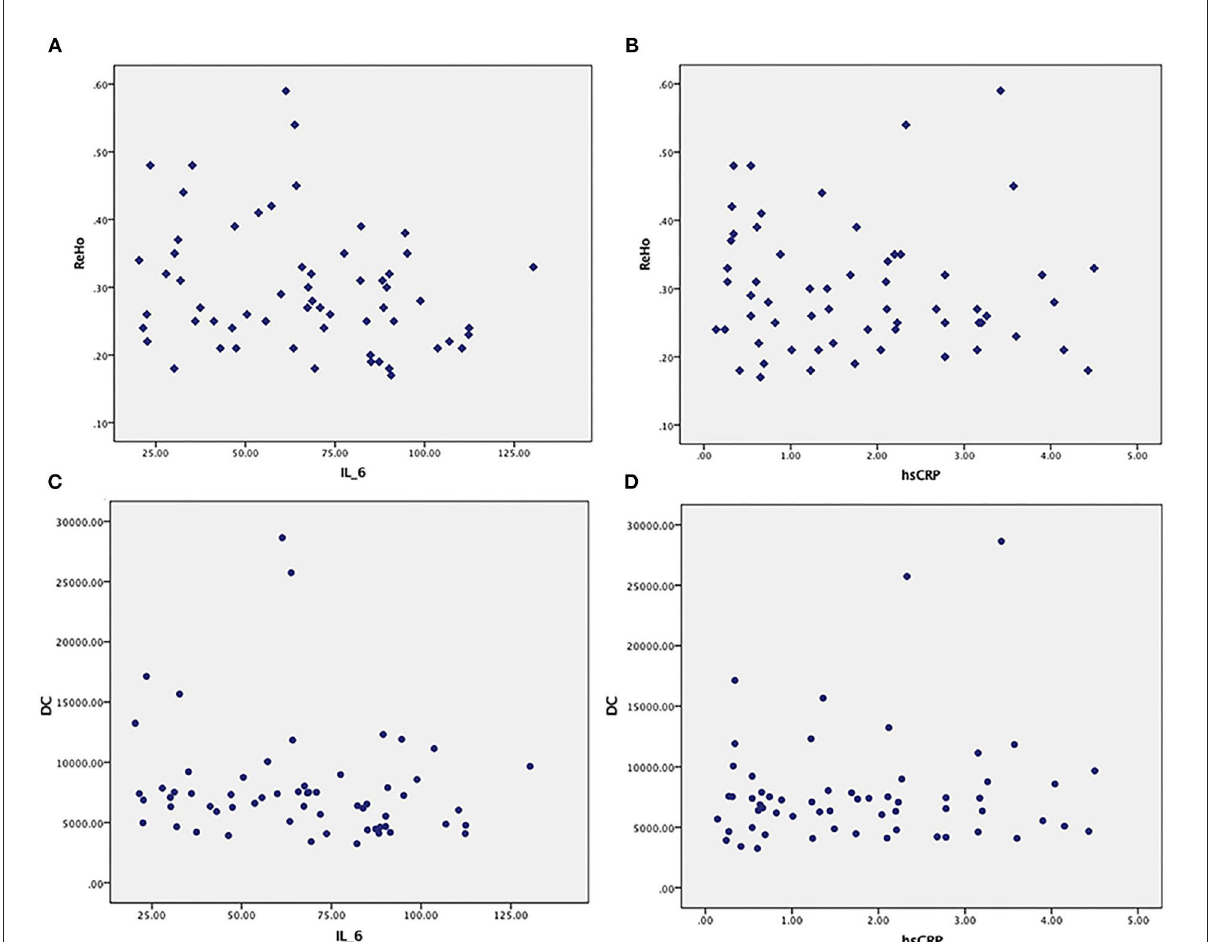
FIGURE5 (A,B) No obvious relationship between ReHo in abnormal brain regions and serum IL-6 or CRP. (C,D) No obvious relationship between DC in abnormal brain regions and serum IL-6 or